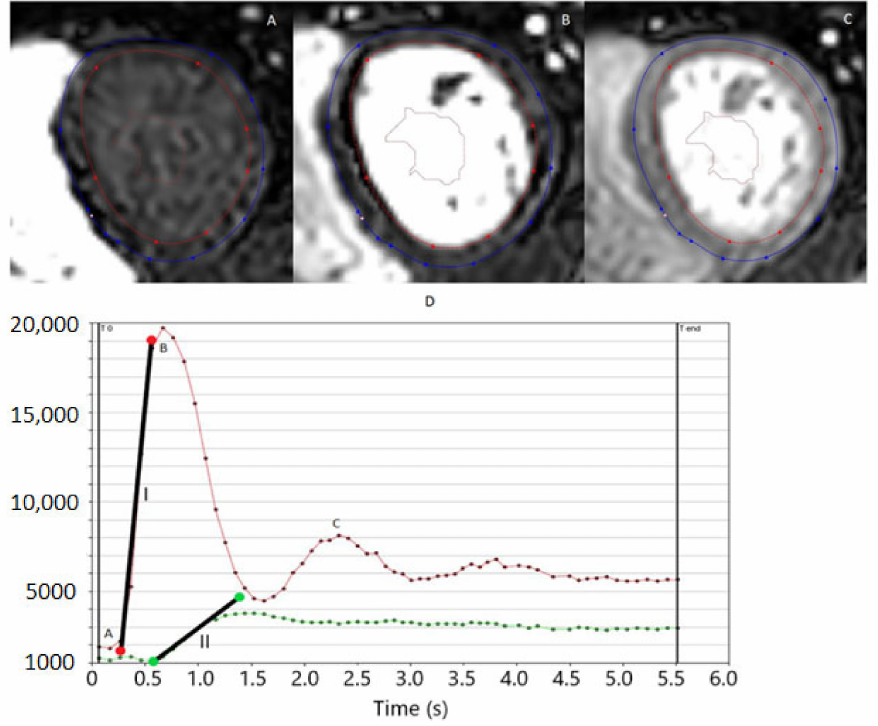
Figure 5. First-pass perfusion. ( A ) shows the contoured mid-height-level myocardium before the first pass of the contrast bolus, though it is already visible in the right ventricle. ( B ) shows the first pass of the bolus as it enters the left ventricle. ( C ) shows the second pass of the bolus, also showing the uptake of contrast agent in the myocardium. ( D ) shows the resulting graphs where signal intensities of the myocardium (green line) and blood pool (red line) are visible. The phases of ( A – C ) are also visible on the graph with their corresponding letters. Line I shows the upslope of the blood pool, and line II shows the upslope of the myocardium, from which the relative upslope is calculated. Time is measured in seconds